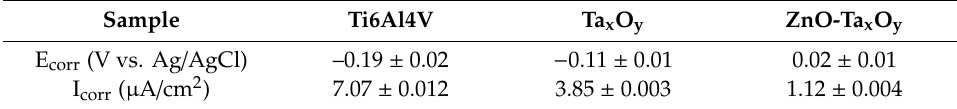
Table 2. Corrosion parameters derived from polarization curves of Figure